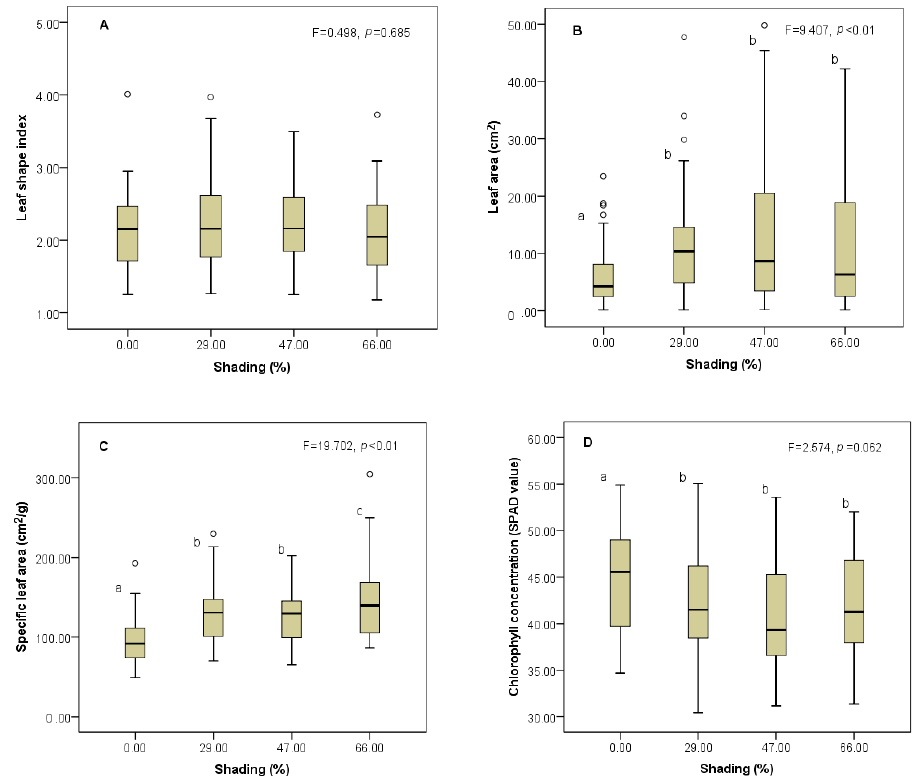
Figure 2. The responses of leaf shape ( A ), leaf area ( B ), specific leaf area ( C ) and chlorophyll concentration ( D ) in different environments with shading gradients. The general linear model was used to test the significant difference of each trait in the four shading gradients (using species and shading as factors), followed by LSD multiple comparison. Here, 0.05 was used as the significance level. The analyzed samples (n = 28) were plant assemblies that emerged in the shaded treatments (n = 4). Box-plots are shown in this figure, and different lowercase letters indicate significant differences among the light treatments.